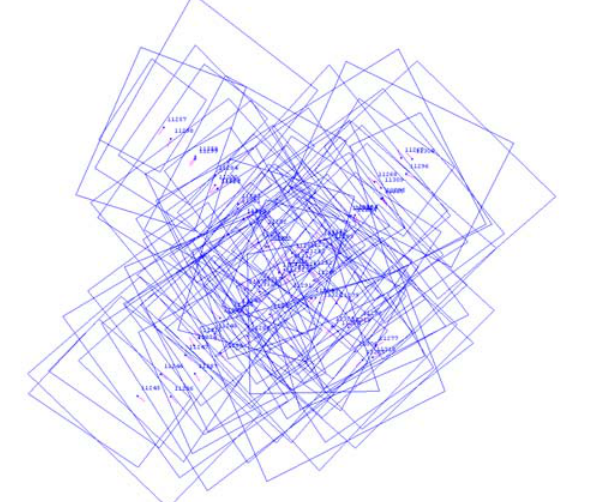
Figure 3: Footprint of the images of the experimental flight. In the centre of the cross, points are visible on more than 30 images. Heading of the images varies a lot in flightlines due to the wind.